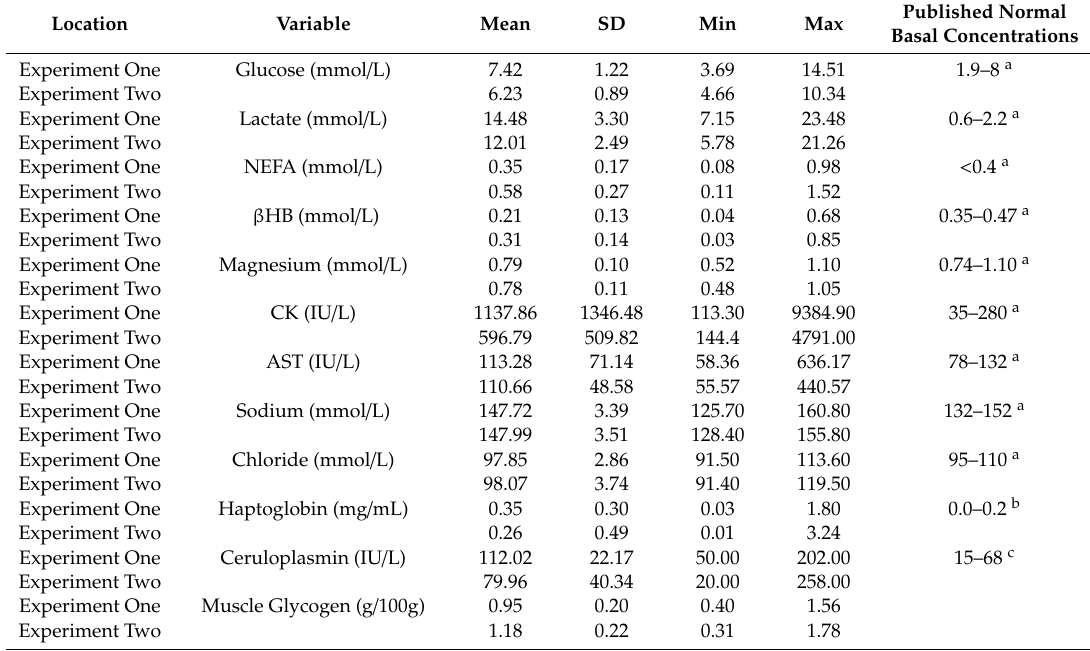
Table5. Descriptivestatisticsofplasmametabolites, enzymesandproteinbiomarkerstakenimmediately at slaughter and M. longissimus lumborum glycogen and